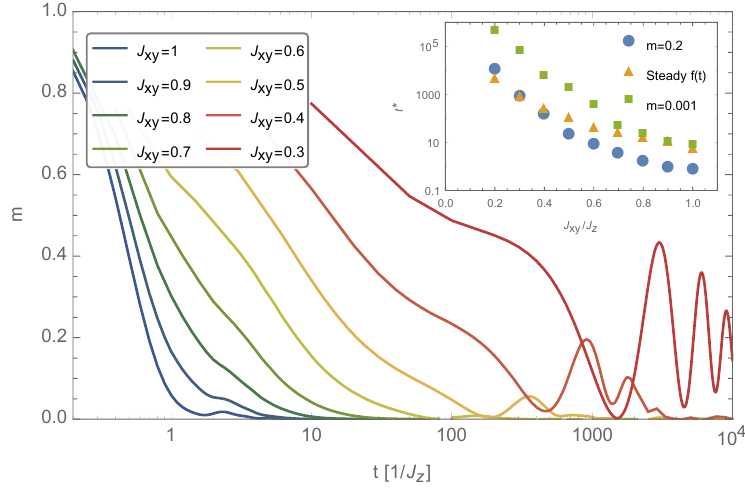
( t ) 〉 after the quench for vari- i